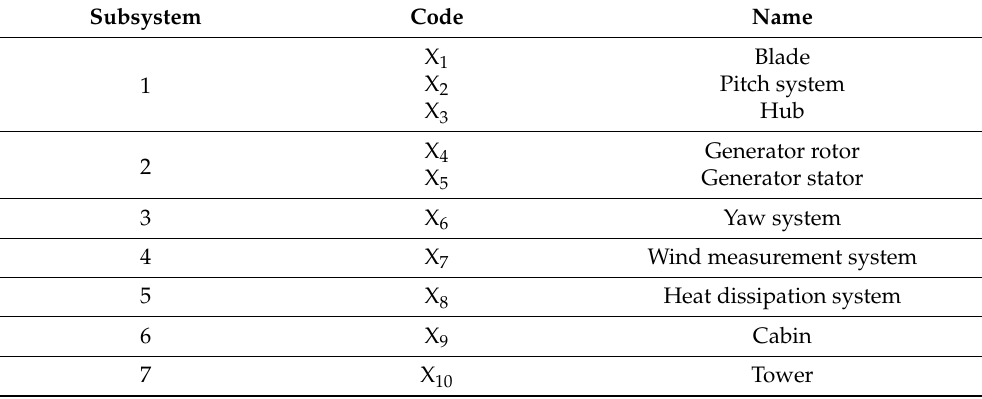
Table 2. The components of a DPM turbine system.